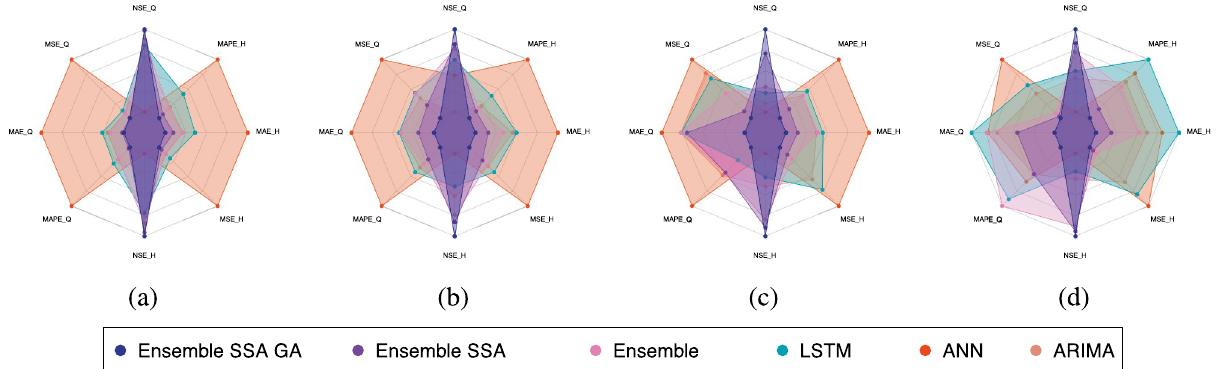
Figure 13. Spider plot indicates all models’ performance. ( a ) Son Tay One-step-ahead ( b ) Son Tay Multi-step- ahead ( c ) Kon Tum One-step-ahead ( d ) Kon Tum Multi-step-ahead. Ensemble SSA GA outperforms the